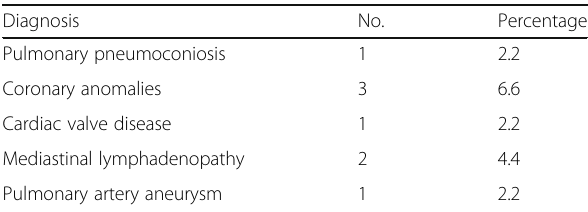
Table 6 Number of patients with significant incidental findings did not explain the presentation of acute chest pain in our